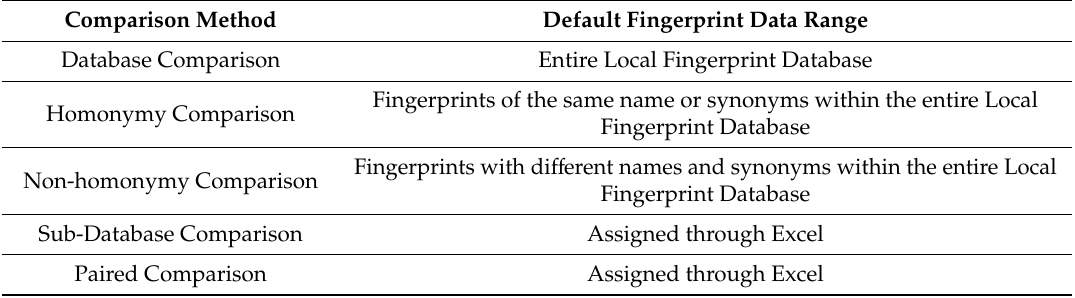
Table 1. Conditions to be specified for the Fingerprint Comparison